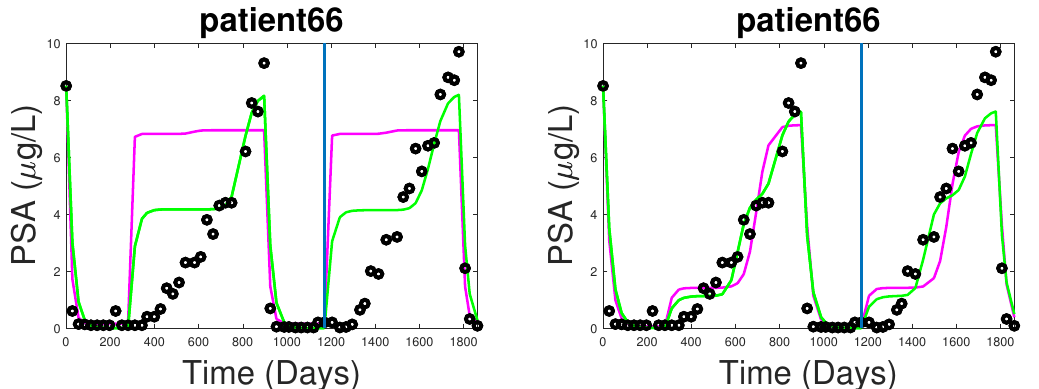
Figure 3. The figures show a case for a patient-specific fitting scheme. The figures represent the fitting and forecasting of the BK model (magenta) and the new model (green). This particular case sees PSA taking an abnormally long time to reach the upper PSA threshold for treatment. (1) Left figure: The weight used across all patients do not work in this case. (2) Right figure: Using a more appropriate weight produces significant